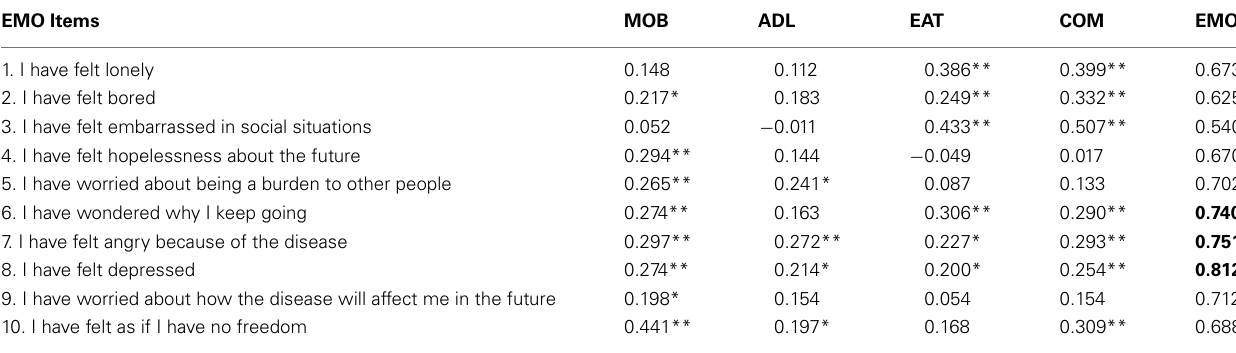
Table 7 | Correlations between EMO items and other areas at the first evaluation. EMO Items